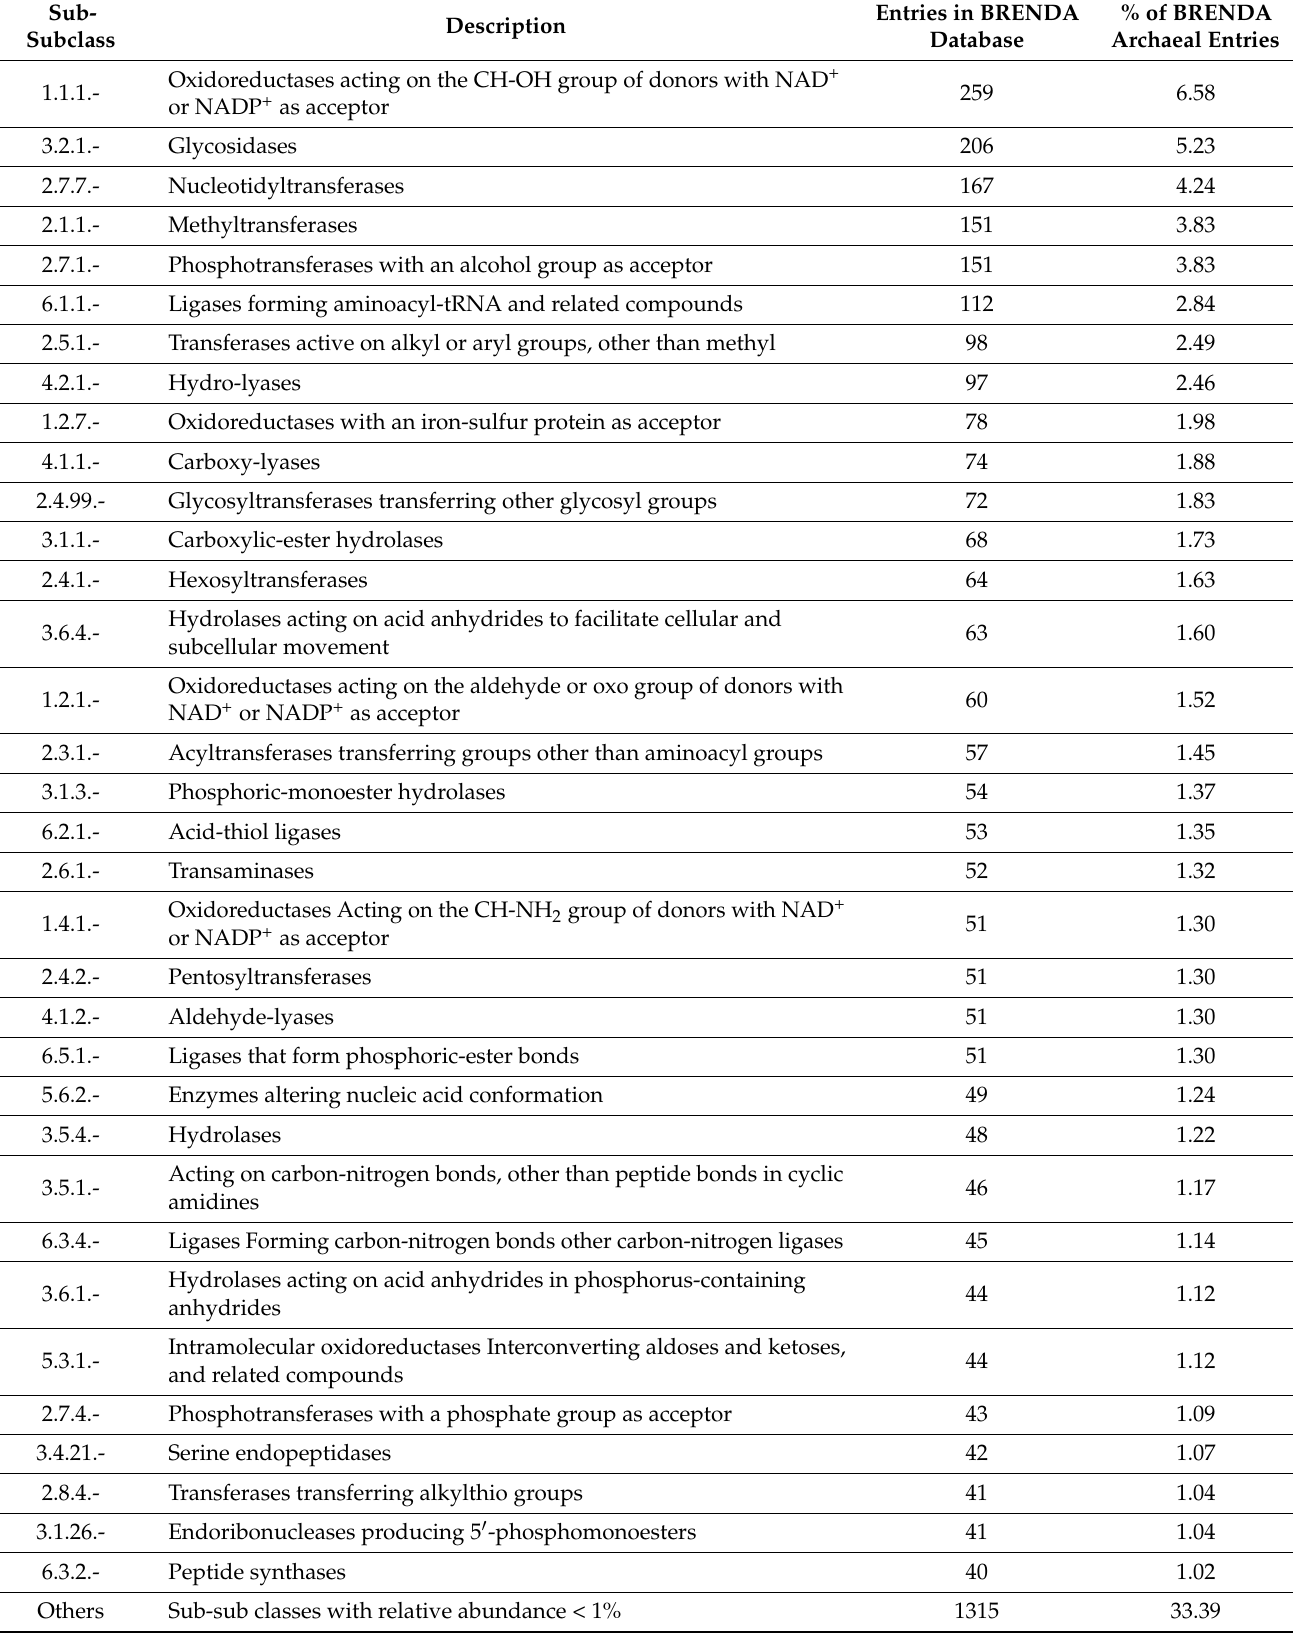
Table 1. Distribution of the sub-sub classes of archaea enzymes in the BRENDA